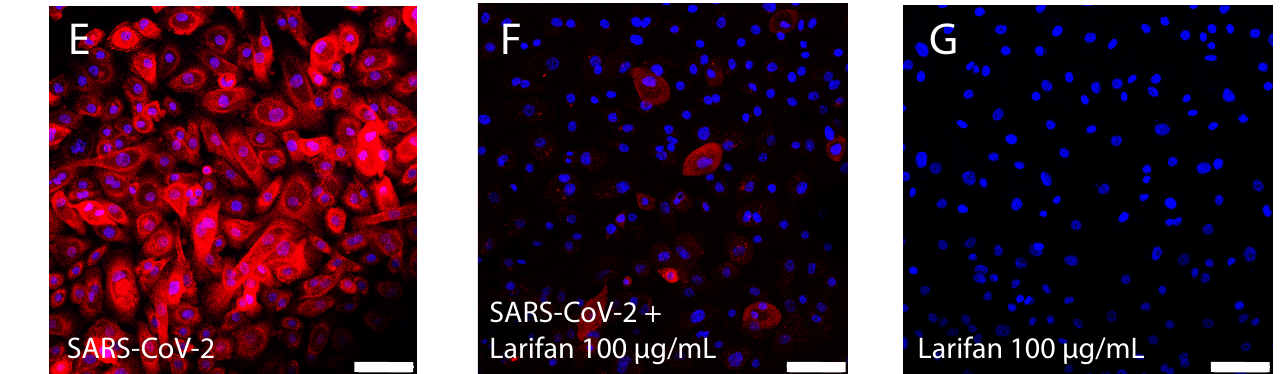
Figure 2. The antiviral activity of Larifan against SARS-CoV-2 in vitro. ( A ) No significant cytotoxicity of Larifan observed in Calu3 cells or HSAEC done in triplicate. ( B ) Viral RNA copy number drop in Calu3 cell supernatants at day three post-infection when Larifan was present throughout the experiment (“full-time treatment”) or added pre- or post-infection and performed in duplicate. ( C ) Infectious SARS-CoV-2 titer drop in Calu3 cell supernatants in paired experiments in Vero E6 cells after treatment with Larifan at day three post-infection when Larifan was present throughout the experiment or added pre- or post-infection. ( D ) Viral RNA copy number drop in HSAEC when Larifan was present throughout and added pre- or post-infection performed in duplicate. Data presented as mean ( ± SD). Statistical significance analysis was performed by using Kruskal–Wallis tests with Dunn’s multiple comparison test. * p < 0.05, ** p < 0.01. ( E – G ) Representative pictures of SARS-CoV-2 NP (red) detection by immunocytochemistry in HSAEC upon treatment with 100 µ g/mL Larifan. Nuclei are counterstained with DAPI. Scale bars 100 µ